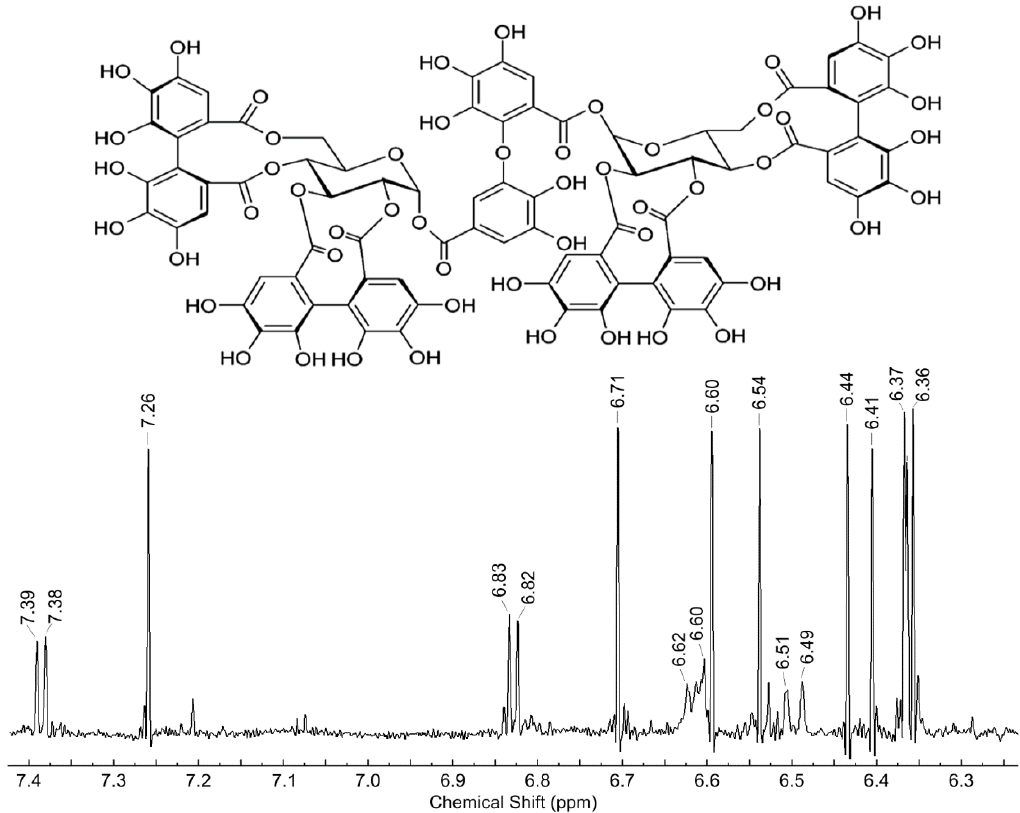
Figure 1. Structure and fragment of 1H NMR spectrum (200 MHz, CD3OD) of aromatic and two H-1 glucose protons of extracted agrimoniin.